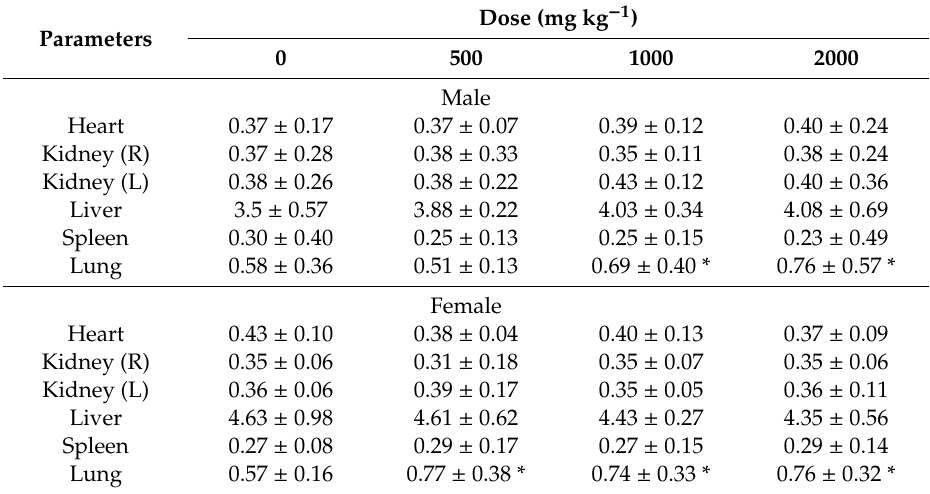
Table 5. Relative rat organ weights after feeding with palm puree for 28 d in a subchronic toxicity study. Parameters